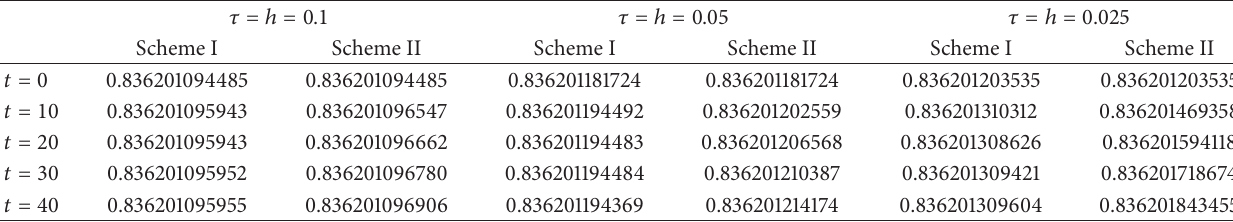
Table 6: When 𝛼 = 1 , numerical simulations on the conservation invariant 𝐸 𝑛